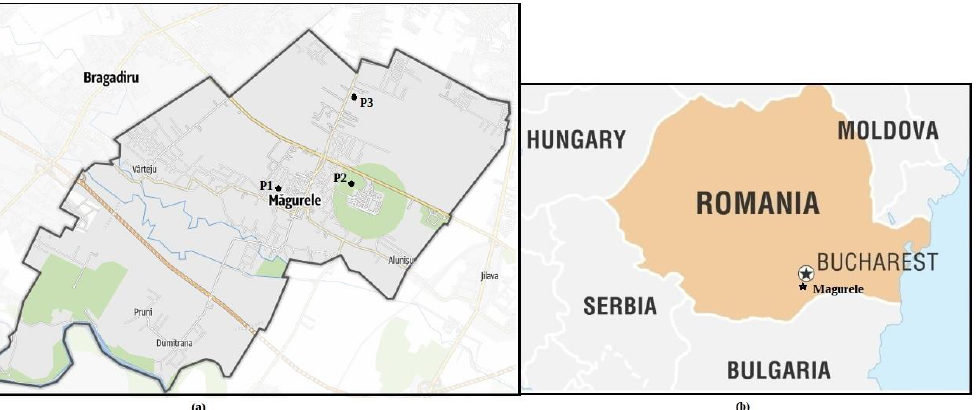
Figure 1. The geographical location of sampling sites: ( a ) Monitoring points P1, P2, and P3; ( b ) the location of Magurele on the map of Romania.